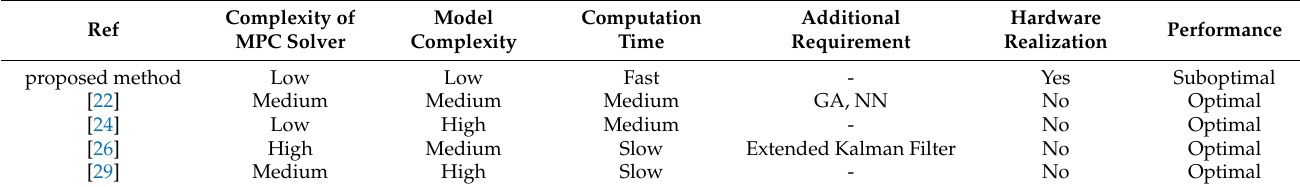
Table 8. Comparison of different MPC-based charging